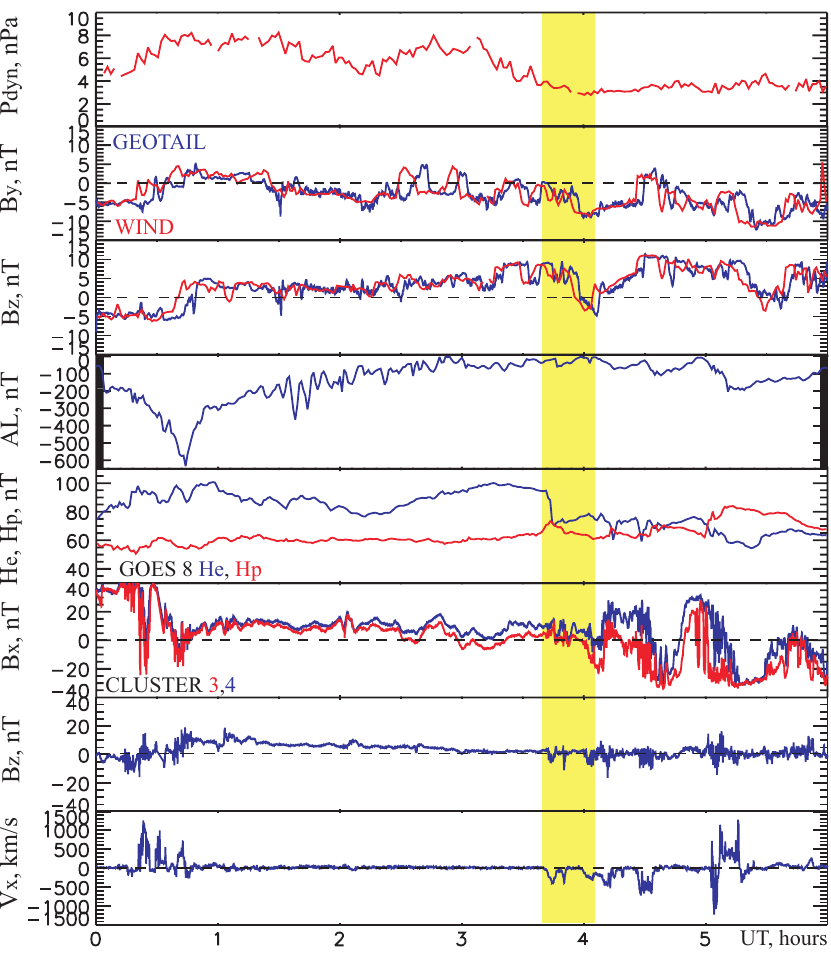
Fig. 1. Solar wind dynamic pressure, IMF B y and B z , AL -index, magnetic field at geostationary orbit, magnetic field ( B x and B z ) and ion bulk velocity ( V x ) observed by C4 (blue) and C3 (red) in the magnetotail during 00:00–06:00UT on 15 September 2001. GSM coordinate system is used for the vector